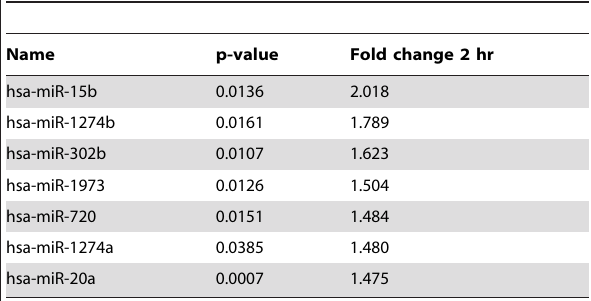
Table 1. Differentially expressed miRNA species in H1 hESC at 2 hr post 1 Gy of X-ray exposures (p , 0.05).